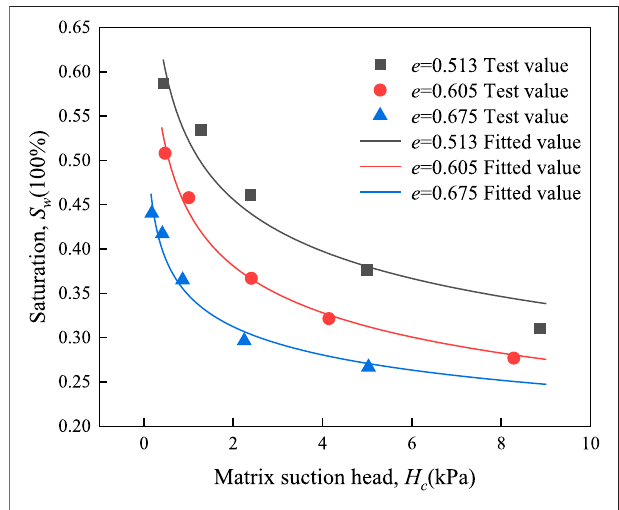
FIGURE 1 | Fitted SWCC with different void